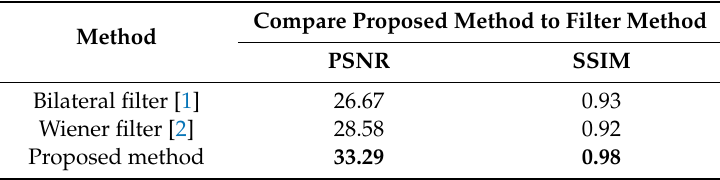
Table 1. PSNR and SSIM on GOPRO Large dataset.